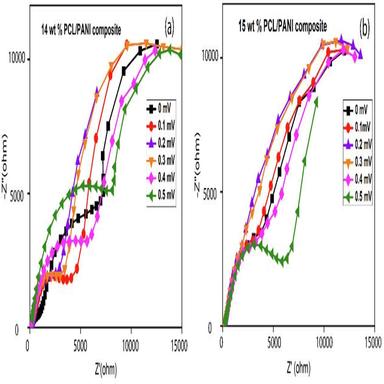
Nyquist plots at different perturbation voltages of (a) 14 wt% and (b) 15 wt% PCL/PANI composites.